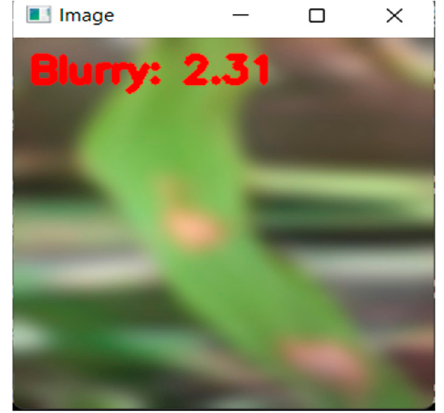
Figure 1. Detected blurry image.